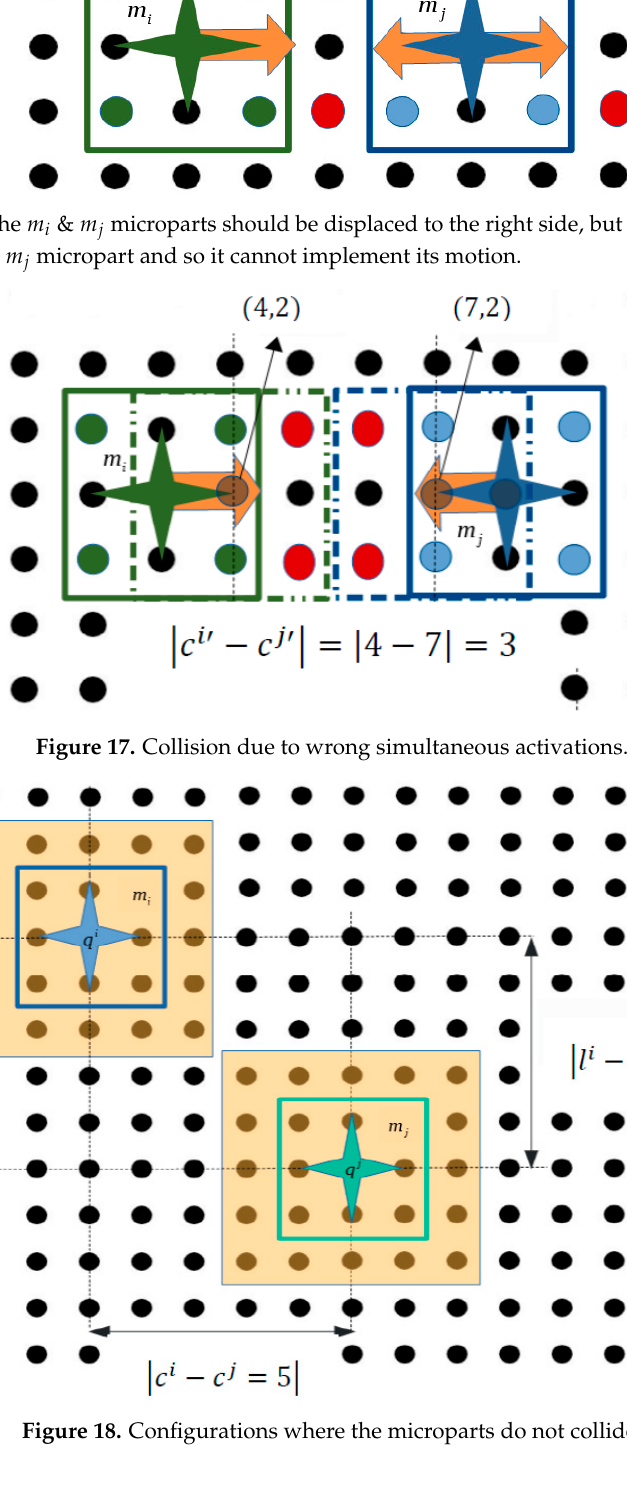
Figure 18. Configurations where the microparts do not collide.